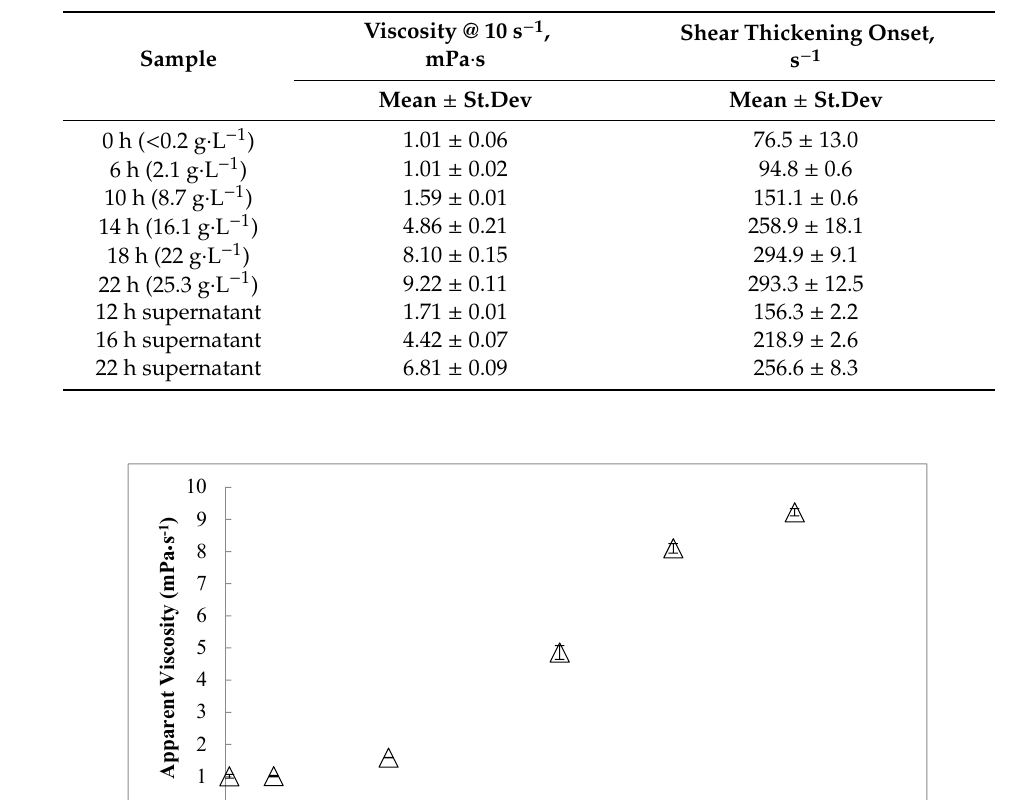
Table 2. Summary of average viscosity at a shearing rate of 10 rad · s − 1 and onset of shear-thickening ( n = 3).